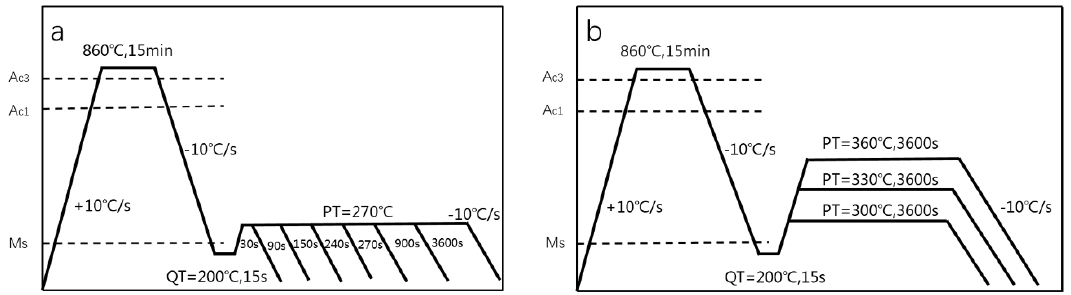
Figure 1. Schematic graph of the quenching and partitioning treatment used in this study. ( a ) Different partitioning times. ( b ) Different partitioning temperature.